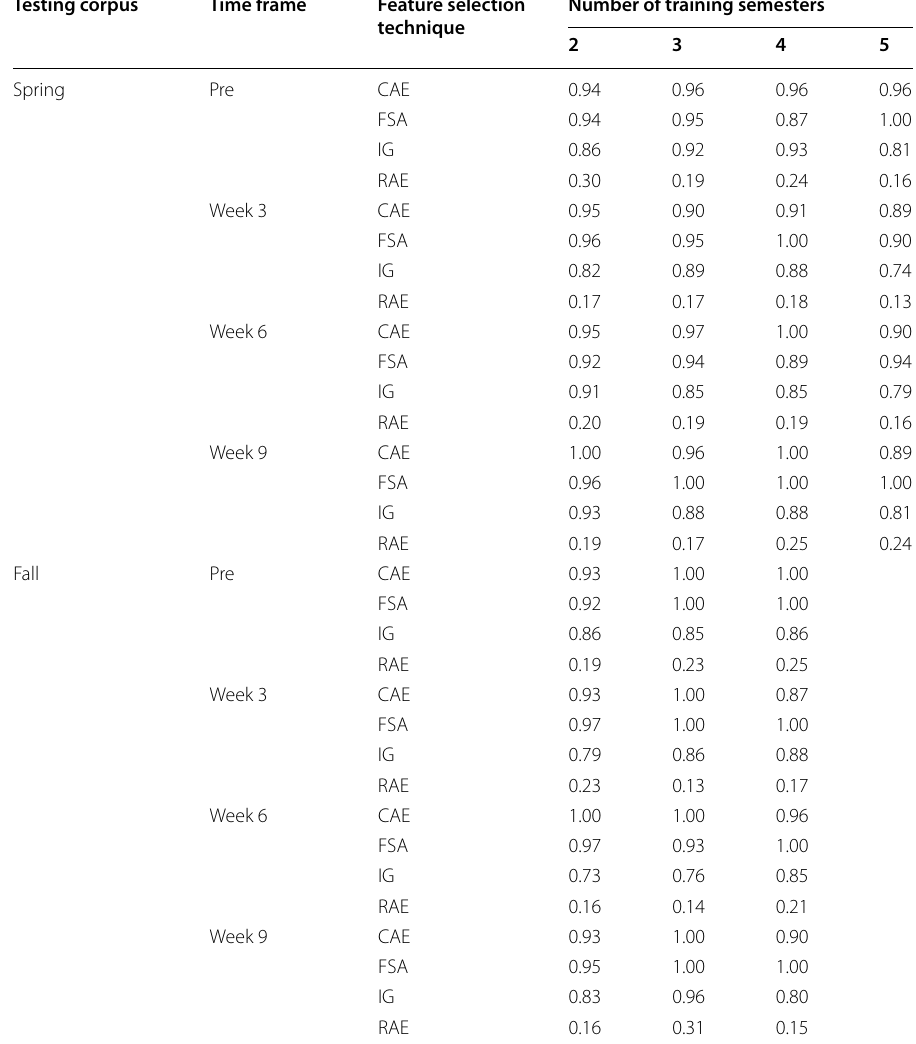
Based on our prediction design, no fall testing corpus was available when five training semesters were used